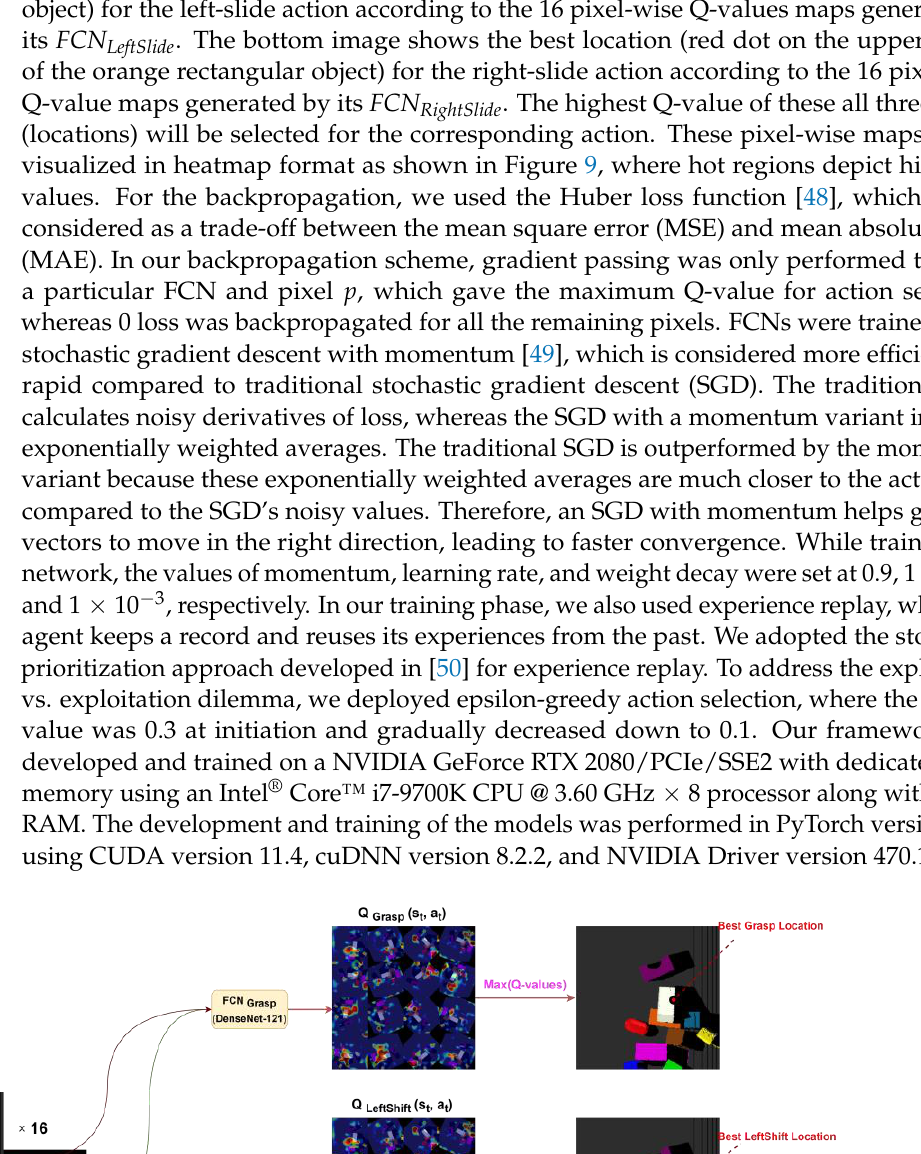
Figure 9. Heatmap visualizations of pixel-wise maps of Q-values generated against 16 rotations of an RGB-D heightmap at 22.5 degrees. DenseNet is one of the most efficient architectures due to its maximized links leading to maximum feature reuse. However, at the same time, if it is not managed properly, due to its contagious convolutional operations its features, maps can start growing quadrati- cally, thus creating a bottleneck in the GPU. Therefore, we implemented a memory-effi- cient variant as in [19], where shared memory schemes are used for concatenation, batch normalization, and gradients. In our simulated environment, all agents are trained via self-supervision through trial and error. At the start of the training process, the workspace on the conveyer belt has N number of regular and irregular objects in a random clutter. The agent starts trying to